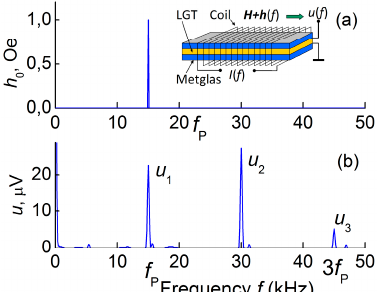
Figure 14. Frequency spectrum of the pump field ( a ) and the generated voltage ( b ) for a nonlinear ME effect in the LGT-Metglas structure.